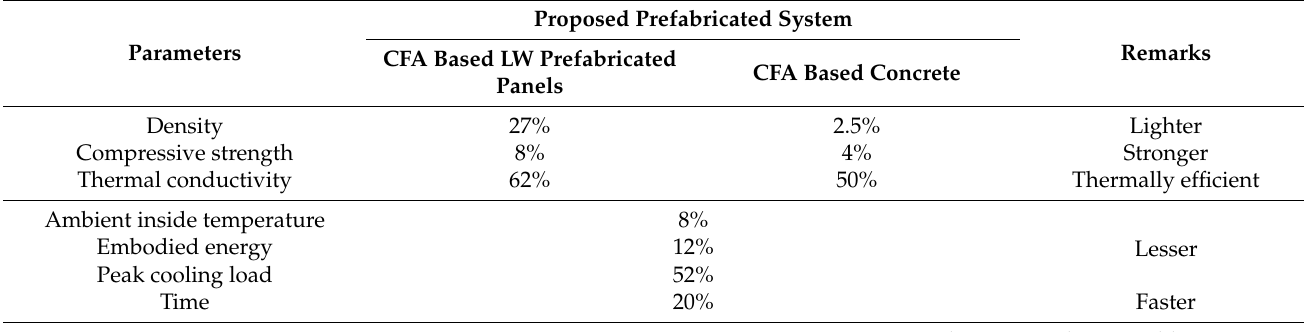
Table 8. Findings of the prefabricated system over the conventional system (in terms of